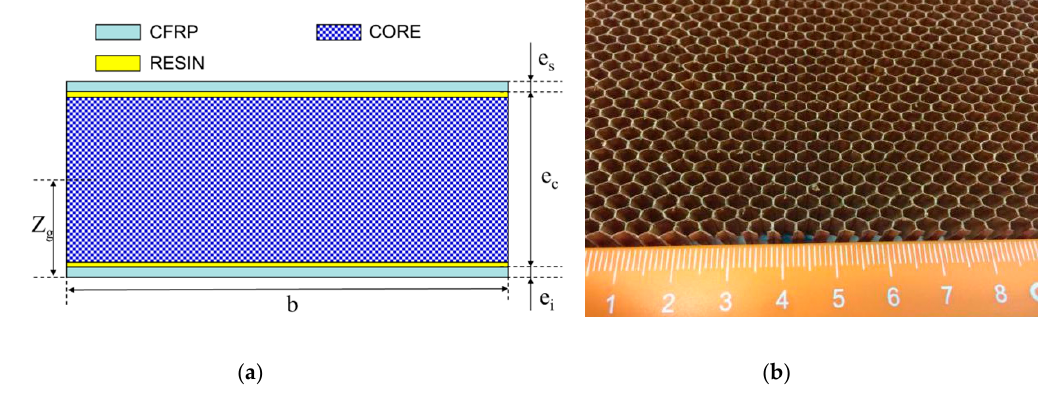
Figure 1. Schematic diagram of Nomex honeycomb sandwich CFRP structure and honeycomb core: ( a ) Nomex honeycomb sandwich CFRP structure; ( b ) honeycomb core (unit: mm).